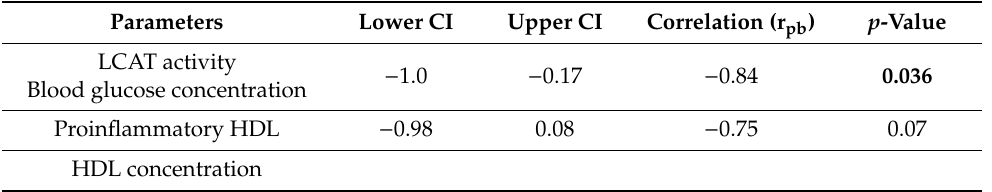
Table 4. Relationships between HDL parameters and T2D